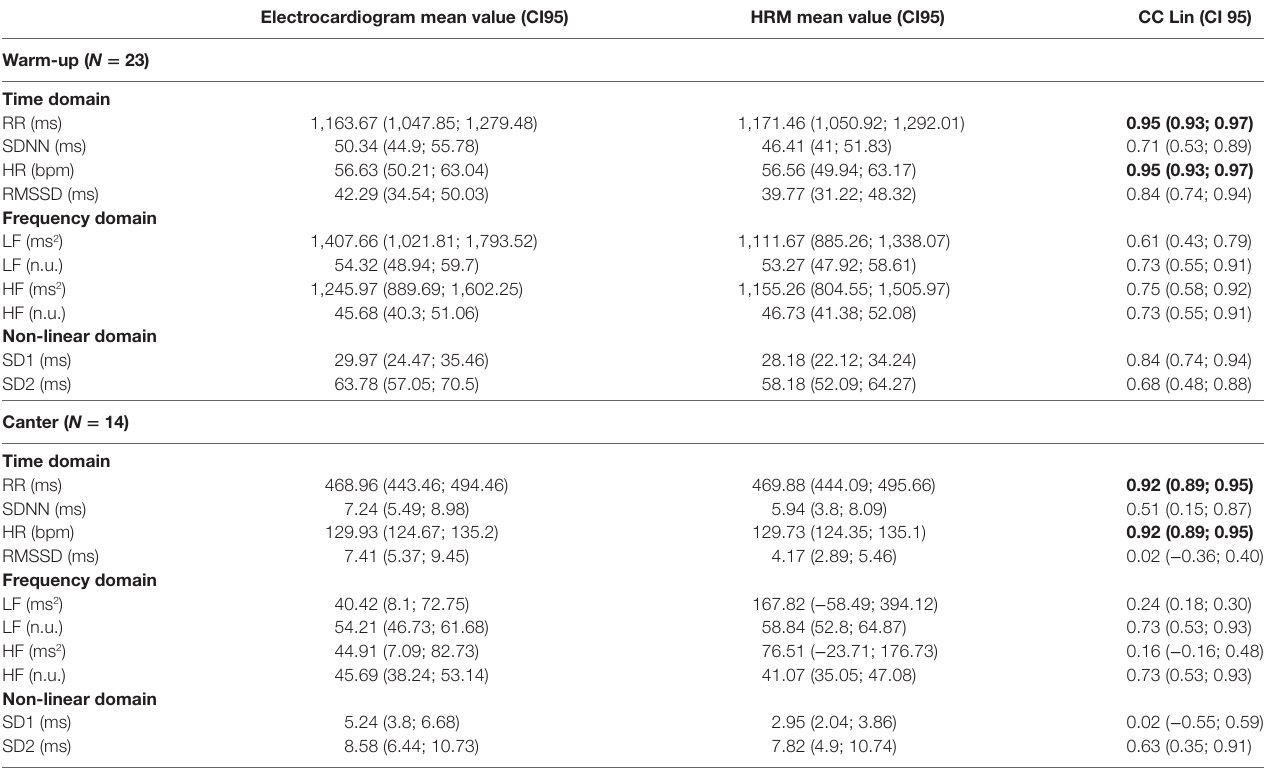
TaBle 3 | Results of Lin’s coefficient (CC Lin) for recordings obtained during the warm-up and the canter phase. electrocardiogram mean value